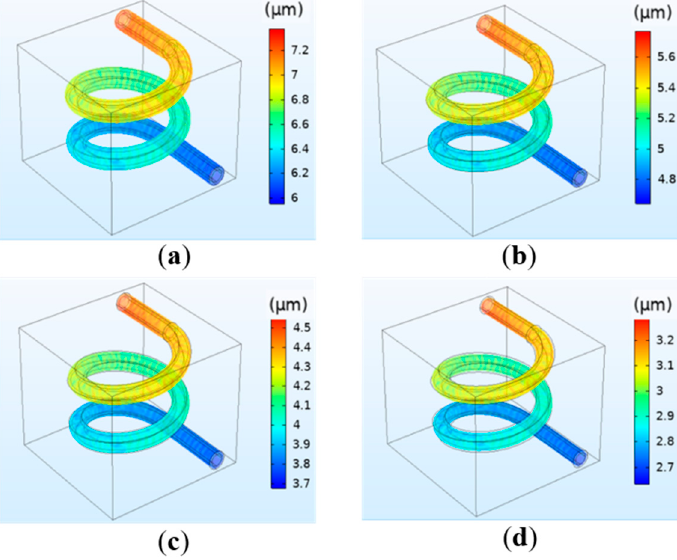
Figure 6. Simulation results of the vessel deformation when the perfusion pressure is fixed at 13 mmHg but the hydrogel concentration changes: ( a ) 20%; ( b ) 30%; ( c ) 40%; ( d ) 50%.